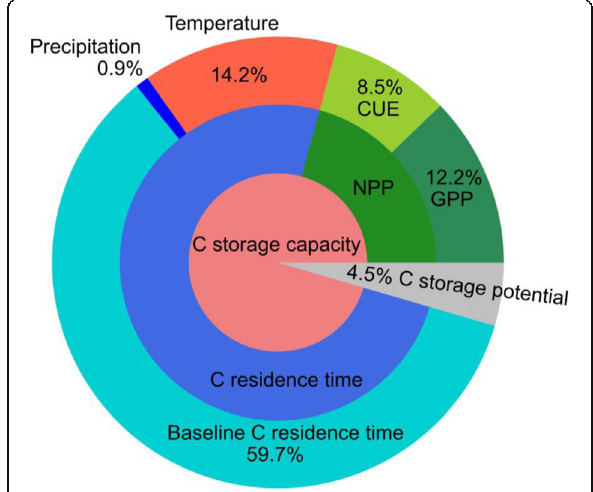
Fig. 5 Variation decomposition of the carbon storage based on annual data from models (CMIP6). The inner-circle indicates the carbon storage is decomposed into carbon storage capacity and carbon storage potential, and their variance contributions. The middle circle represents the carbon storage capacity is decomposed into net primary productivity (NPP) and carbon residence time, and their variance contributions. The outside circle indicates that the NPP is decomposed into gross primary productivity (GPP) and carbon use efficiency (CUE), and carbon residence time is decomposed into baseline carbon residence time and environmental scalars (temperature and precipitation), and their variation contributions to carbon